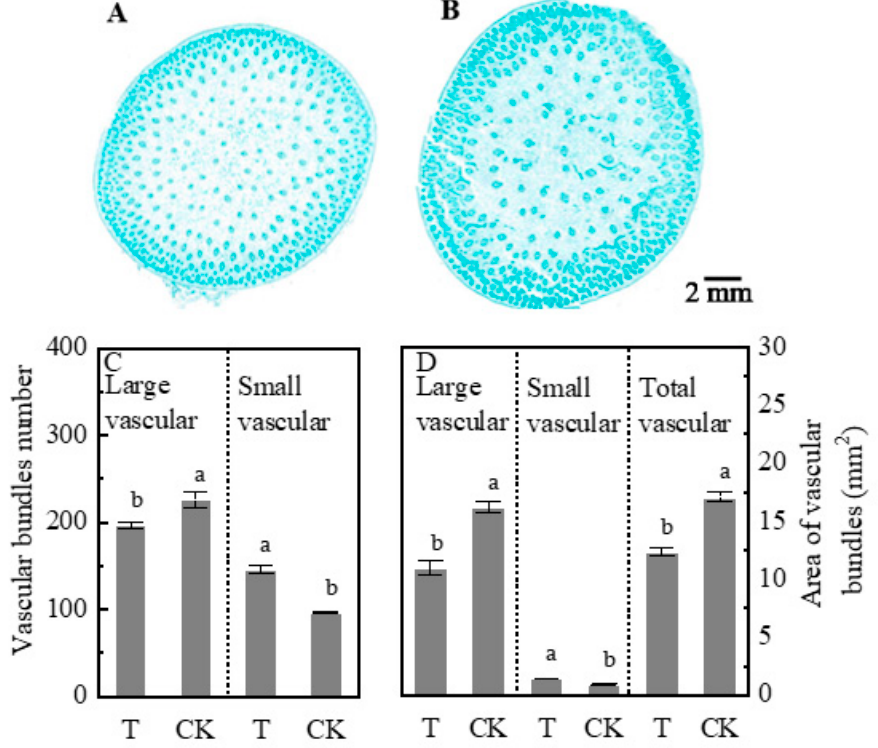
Figure 7. The number of large and small vascular bundles. The cross-sectional area of large and small vascular bundles and the number of vascular bundles in an ear stem. Small vascular bundles are numerous, small, and closely arranged in the peripheral portion. Large vascular bundles, towards the center, the bundles are comparatively large in size and loosely arranged. ( A ): T treatment; ( B ): CK. Scale bar, 2 mm, ear stem in full sunlight; ( C ): vascular bundles number; ( D ): area of vascular bundles. Plants grown under heterogeneous light (T). All leaves were under full sunlight (CK). Data with di ff erent letters are significantly di ff erent ( p <